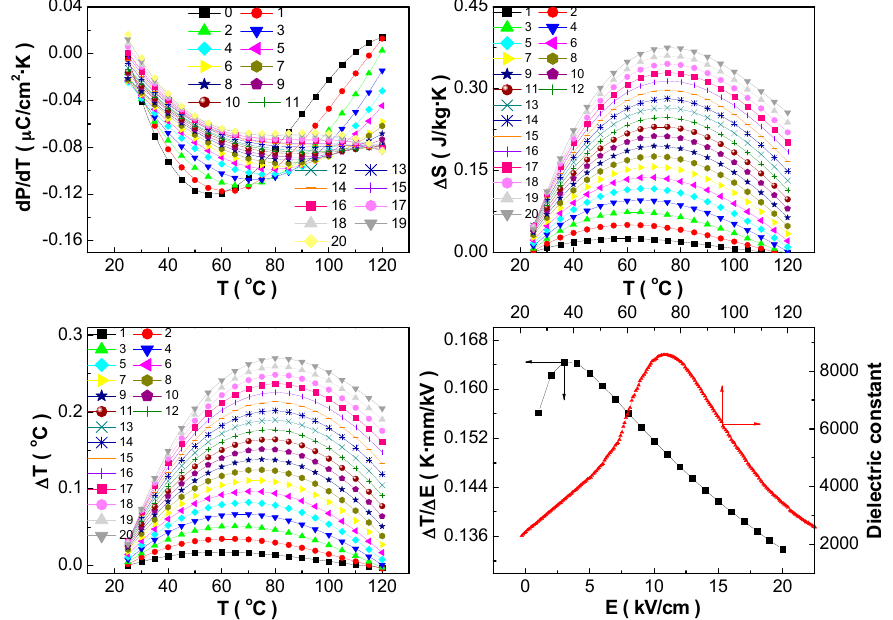
Figure 3. Temperature dependence of dP / dT , ∆ S and ∆ T at different electric fields, and dielectric constant shown the ferroelectric phase transition temperature; and electric field dependent electrocaloric responsivity of the BCZT-Li ceramics. The unit of the electric field shown by different lines and symbols in the figure is kV/cm.